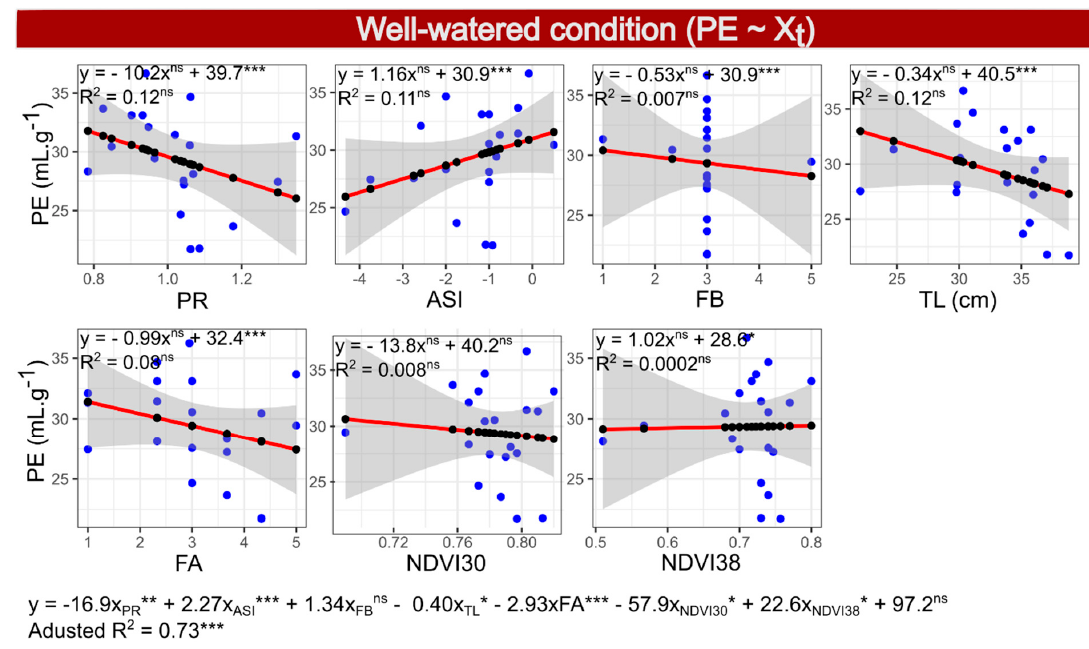
Figure 5. Simple linear regressions (within boxes) and multiple regressions (below the boxes) between the dependent variable popping expansion (PE) and independent variables prolificacy (PR), anthesis-silking interval (ASI), leaf rolling (FB), tassel length (TL), leaf angle (FA) and normalized difference vegetation index evaluated at 30 (NDVI30) and 38 (NDVI38) days after anthesis, evaluated in 20 popcorn inbred lines under well-watered conditions.